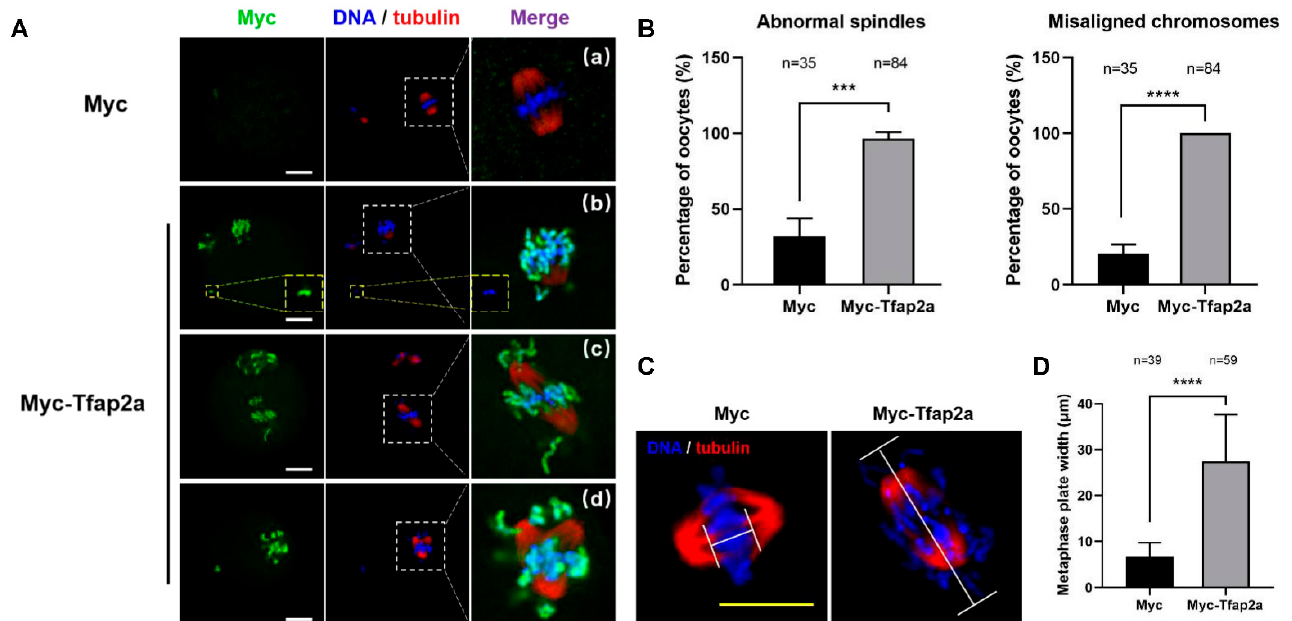
Figure 5. Overexpression of Tfap2a caused abnormal spindles and misaligned chromosomes in mouse oocytes. ( A ) Abnormal spindle and chromosome alignment in MII oocytes after the microinjection of Myc-Tfap2a mRNA. In the Myc group, most oocytes showed normal spindle and chromosome alignment (a), whereas in the Myc-Tfap2a group, Myc-Tfap2a protein was colocalization with nuclear DNA, and the chromosomes were severely misaligned in most oocytes. Some chromosomes moved to the poles of the spindle or were largely scattered in the cytoplasm (b and c), and the spindles showed unattached microtubules (b), which were severely disrupted or multipolar (d). Magnifications of the boxed regions are shown on the right of each main panel. Myc is shown in green, tubulin in red, and DNA in blue. Scale bar = 20 µm. ( B ) The rates of oocytes with abnormal spindles or misaligned chromosomes after overexpression of Myc or Myc-Tfap2a. The data are expressed as the mean ± SEM of at least three independent experiments. *** p < 0.001, **** p < 0.0001. ( C ) The MI oocytes stained by anti-tubulin (red) and Hoechst 33342 (blue). Scale bars: 20 µm. ( D ) The width of the metaphase plate measured by the axis-to-axis distance between the two lines at the edges of the DNA in ( C ). The data are expressed as the mean ± SEM of at least three independent experiments. **** p < 0.0001.